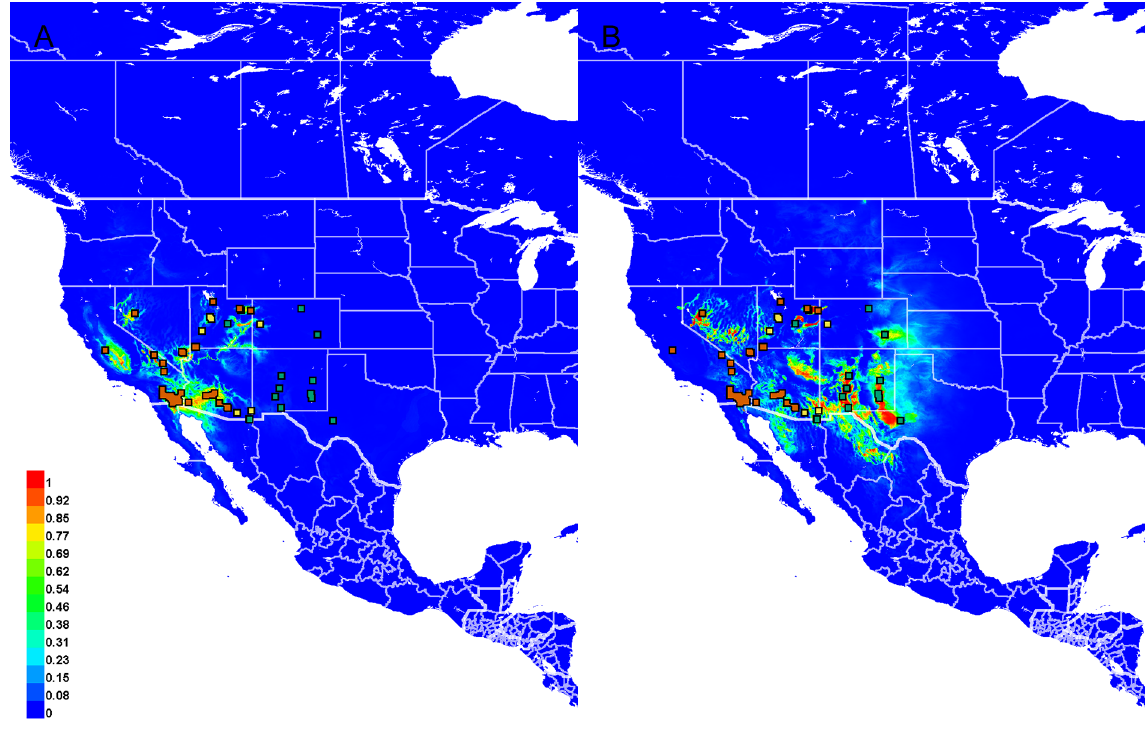
Fig. 51. Georeferenced collection records of Lasioglossum ( D. ) kunzei (Cockerell, 1898) (vermilion squares), L. ( D. ) semibrunneum (Cockerell, 1895) (blue-green squares) and intermediate specimens of uncertain identity (yellow squares) as well as predicted distribution by maximum entropy ecological niche modeling in Maxent (colour shading). Warmer colours indicate higher cloglog probability of occurrence. Maxent analysis was run separately for L. ( D. ) kunzei (left) and L. ( D. ) semibrunneum (right), but all georeferenced records for both species are shown on both maps to highlight distributional differences. Lasioglossum ( D. ) kunzei and L. ( D. ) semibrunneum have largely non-overlapping distributions, but are predicted to intermix in northern Utah, southern Arizona/northern Sonora, and northern Nevada (although no L. ( D. ) semibrunneum records are known from